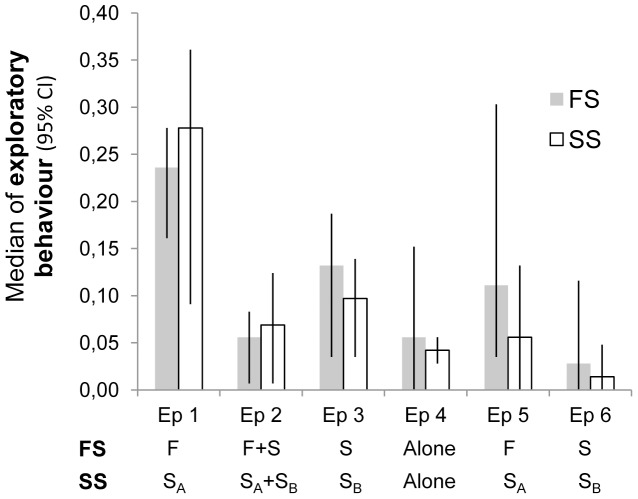
Exploration levels in both treatments during the test.Level of exploration (median proportion of sample points/episode presented together with 95% confidence intervals) across the whole test procedure (episode (Ep) 1–6) in treatment FS and treatment SS. F = familiar person, S = stranger, SA = stranger A and SB = stranger B.